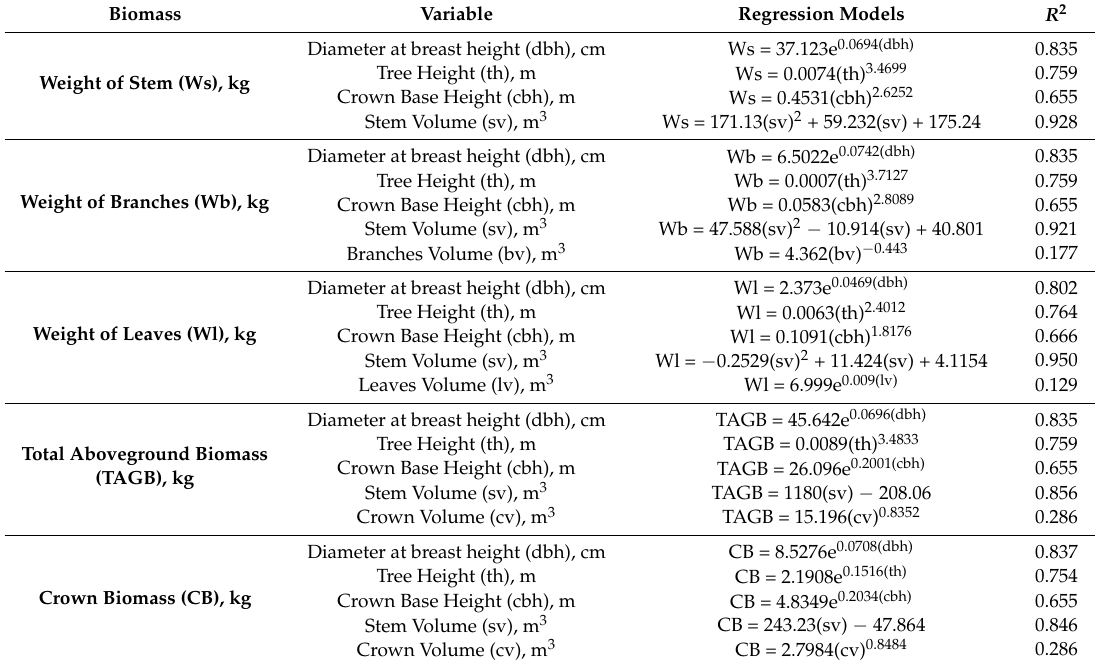
Table A8. Allometric equation generated for other trees with tree variables obtained from TLS. Biomass Variable Regression